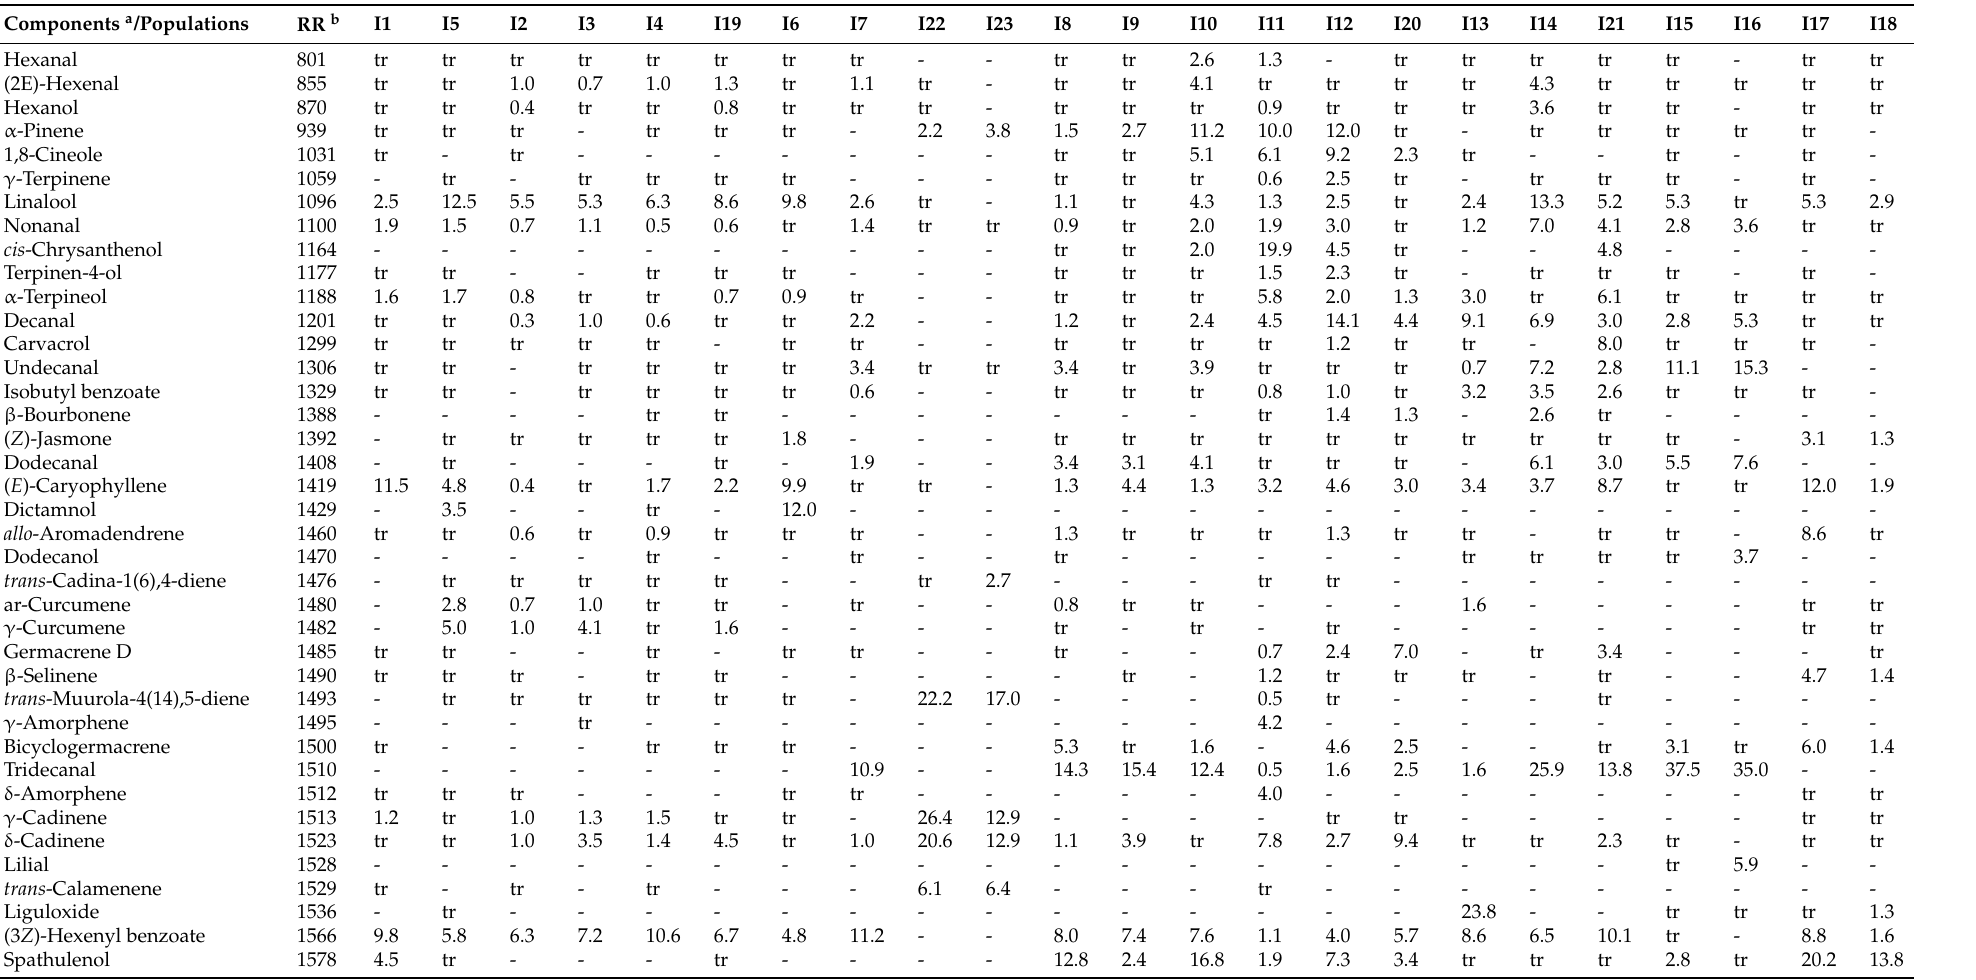
Table 2. Chemistry of the essential oils obtained from the aerial parts of the Inula candida and I. verbascifolia members, together with the related I. subfloccosa. Numbers refer to percentages (%), estimated in relation to the total oil